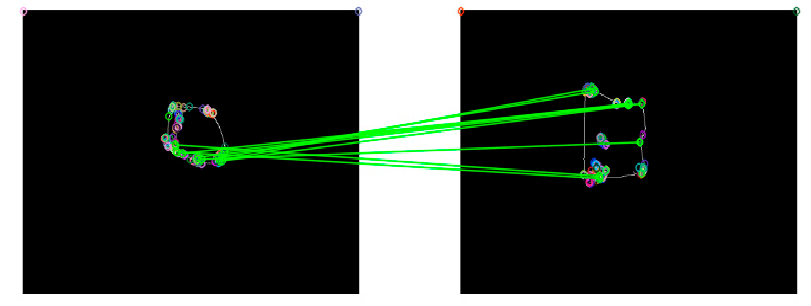
Figure 4. ORB feature extraction.